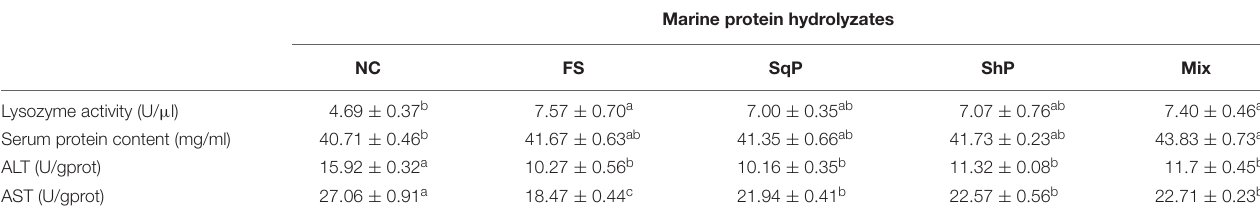
TABLE 7 | Non-specific immune response and hepatic transaminase activities of largemouth bass fed the experimental diets for 81 days*.